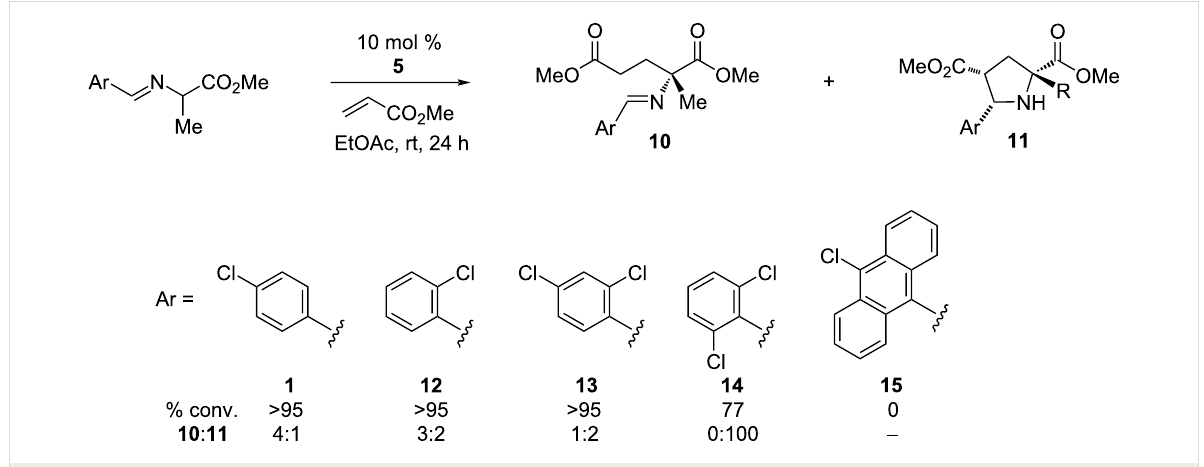
Figure 2: Effect of the aryl substituent on reaction efficiency and selectivity.